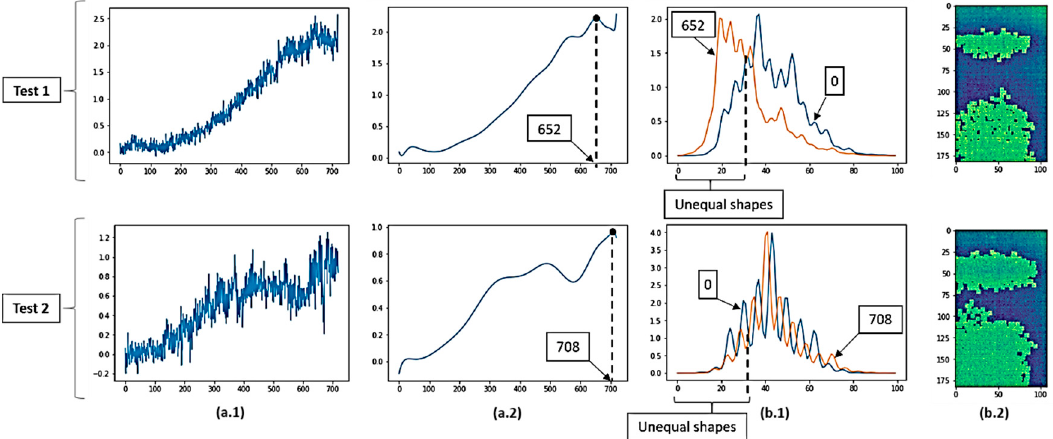
Figure 2. ( a.1 ) 1st Criterion: summation of the skew and kurtosis values along each of the sequences; ( a.2 ) 1st Criterion: polynomial adjustment of the sum of skew and kurtosis, searching maximum peaks that meet the 1st criterion (black circles); ( b.1 ) 2nd Criterion: search of unequal shapes between the maximum temporal instances (1st criterion) and the initial temporal instant; ( b.2 ) 2nd Criterion: delimitation of the unequal shapes as green areas.